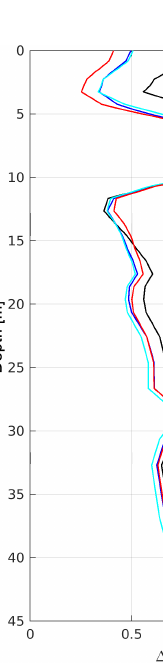
Figure 18. ROMS runs D1–D4: the rms temperature differences (cid:49)T between the modelled temperature T ROMS and the observed temperature T obs evaluated at the actual depths of the observations. (cid:49)T was computed only for the period after 15 June at